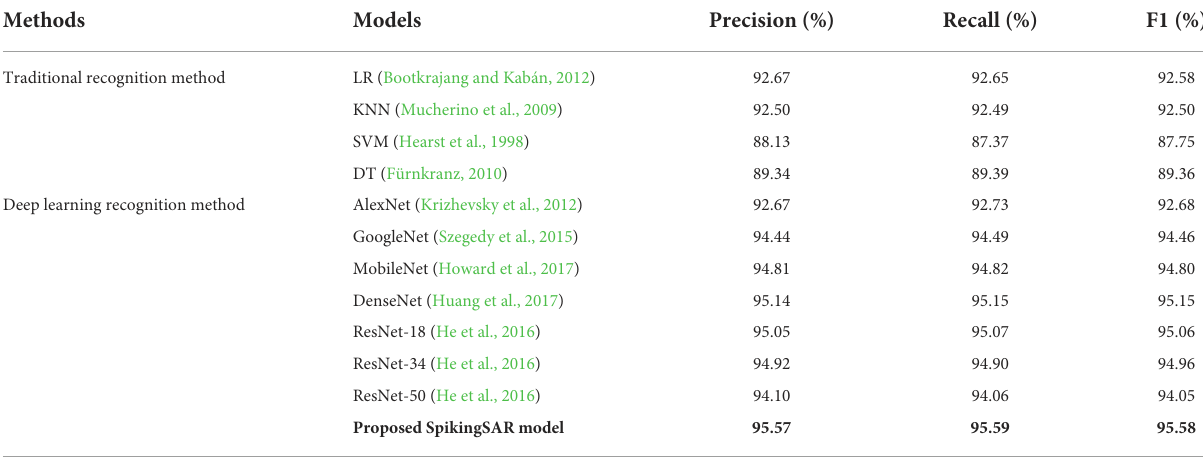
TABLE 1 Ship recognition results of different models.